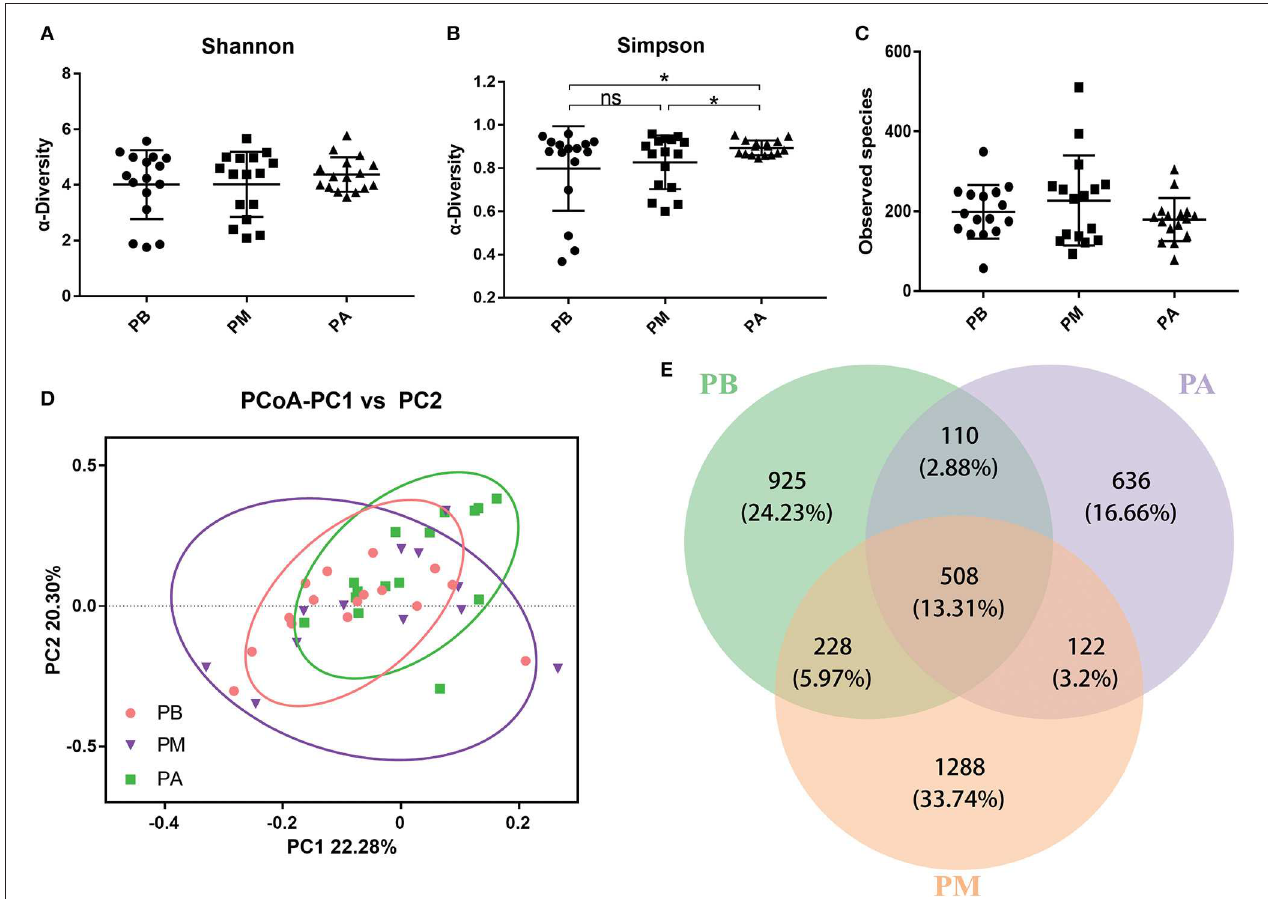
FIGURE 3 | Effect of probiotics on intestinal microbiota. (A) , Shannon index; (B) , Simpson index; (C) , Observed species; (D) , PCoA of β diversity index; (E) , scalar-Venn representation. PB, probiotic group 3 days before bowel preparation ( n = 16); PM, control group during bowel preparation ( n = 16); PA, probiotic group 5–7 days after bowel preparation (Supplement the Bifidobacterium Tetragenous viable Bacteria Tablets after colonoscopy for up to 5–7 days, three tablets and three times a day) ( n = 16). Data are presented as means ± SD. ns, P > 0.05; * P <